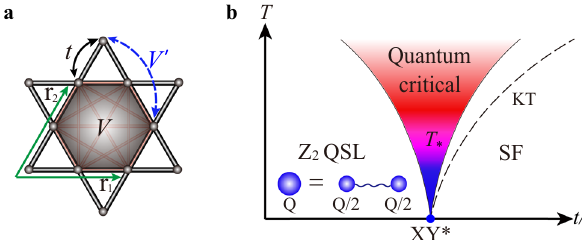
Fig. 1 Kagome model for a topological phase transition. a Kagome lattice with lattice vectors r 1,2 . The hopping t and the interaction V are given in the Hamiltonian Eq. (1). b Phase diagram of the kagome model as a function of t / V , and temprature T . The Z fl uid (SF), 2 quantum spin liquid (QSL), super and the XY * quantum critical point characterizing the ground state are shown. The charge fractionalization of spinons is schematically illustrated. In the quantum critical fan, blue indicates a particle-like conductivity, while an unconventional vortex-like response is in red. A nearly self-dual dynamical conductivity emerges at intermediate temperatures (purple) signaling the presence of visons. The same color scheme is used in representing the conductivity data in Figs. 2 and 3. The SF long-range order only exists at zero temperature; a Kosterlitz – Thouless (KT) transition, denoted by the black dashed line, separates the paramagnetic phase from the one with quasi-long-range